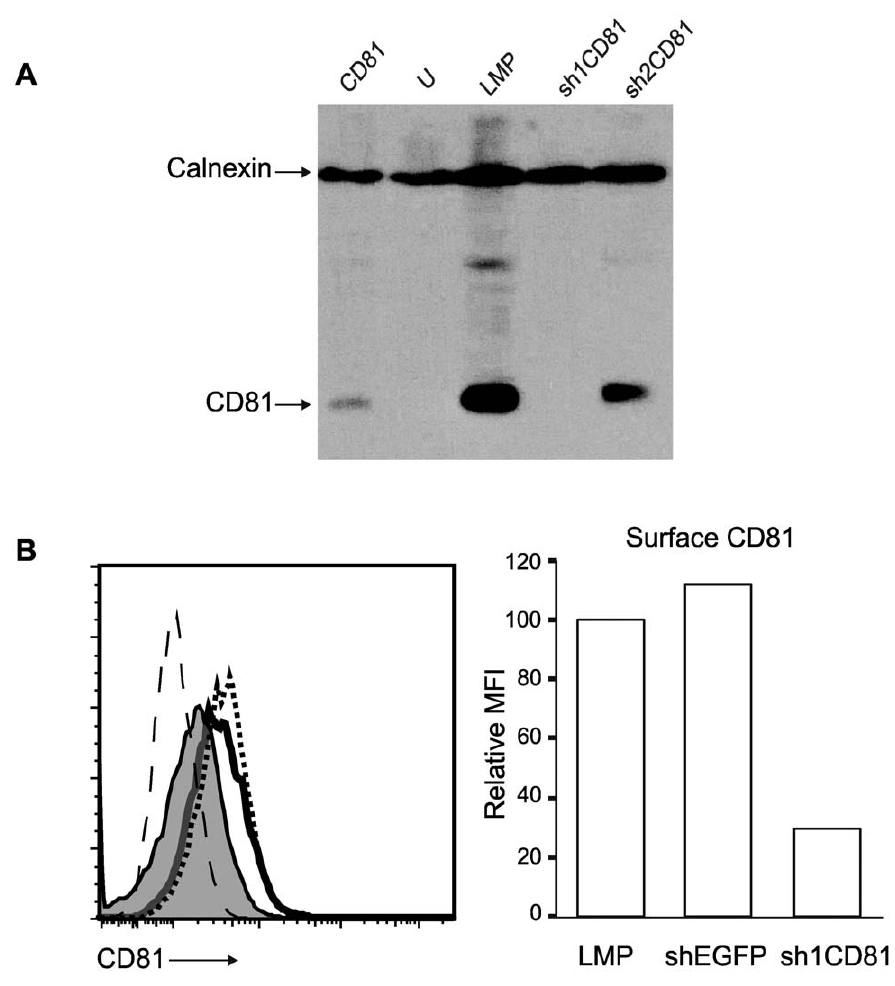
Figure 2. CD81shRNAs knock down CD81 protein expression and surface CD81 expression. ( a ) HA-CD81 transfected HEK293T cells with or without shRNA expression were solubilized in Triton X-100 detergent and resolved by reducing SDS-PAGE and blotted with anti-HA Ab. Lysates from HEK293T cells expressing HA-CD81 alone (lane1), untransfected cells (lane 2), cells expressing HA-CD81 plus empty pLMP shRNA expression construct (lane 3) and HA-CD81 plus sh1CD81 or sh2CD81 expressing pLMP constructs (lanes 4 and 5 respectively) were blotted with anti-HA Ab revealing a 26 KDa HA tagged CD81 band. Equal loading was confirmed by blotting the same membrane with anti-calnexin Ab revealing a 90 KDa calnexin band. ( b ) NIH3T3 cells infected with retrovirus coding shRNA against EGFP (shEGFP) (heavy dotted histogram), empty pLMP shRNA expression construct (solid histogram) or sh1CD81 expressing pLMP construct (tinted histogram) were stained with anti-CD81 biotin followed by streptavidin-PE. Histograms show surface CD81 levels of the cells. The relative mean fluorescence intensity (MFI) normalized to CD81 expression on empty LMP transfected NIH3T3 cells (set to 100) is plotted as a bar graph.